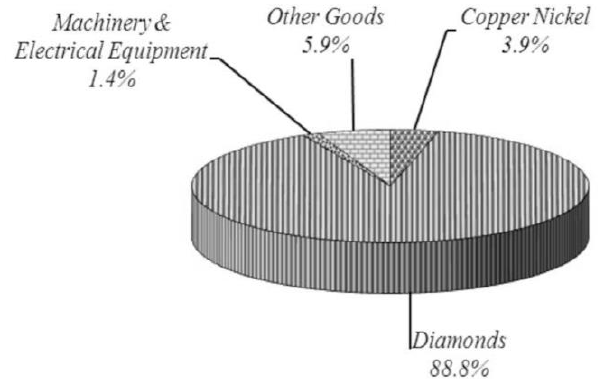
Figure 1: Botswana exports composition–Nov. 2013 Source: Statistics Botswana